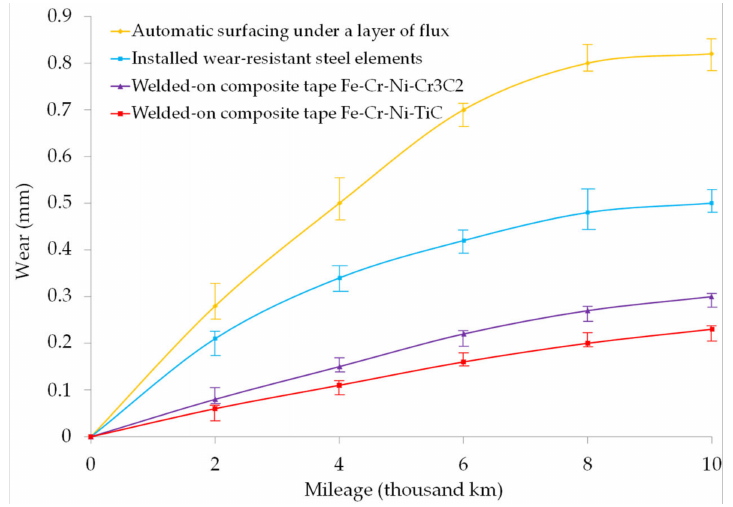
Figure 8. Dependences of the total value of the wear of the center plate assembly for the case of a full load of a freight car on the mileage for the repaired CBRTB in function of the